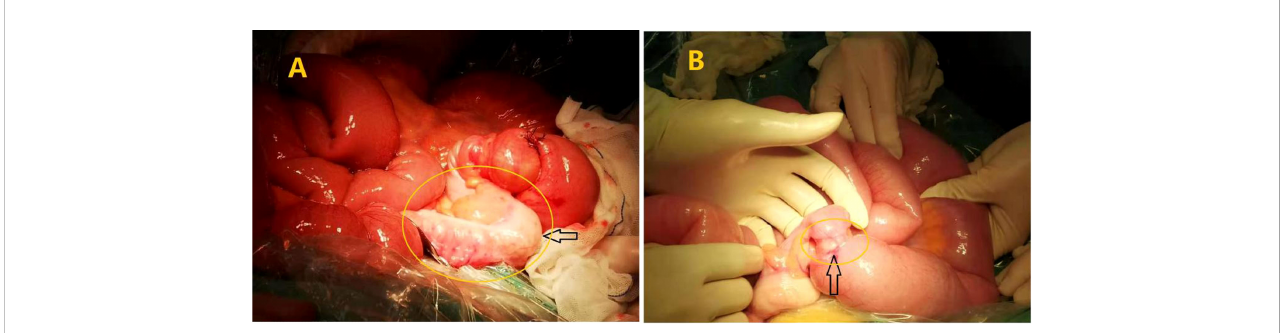
FIGURE 2 Surgical fi nding: (A) The cancer caused this part of the ileum to become ischemic and pale; (B) Annular stenosis in the ileum is indicated by the yellow circles.